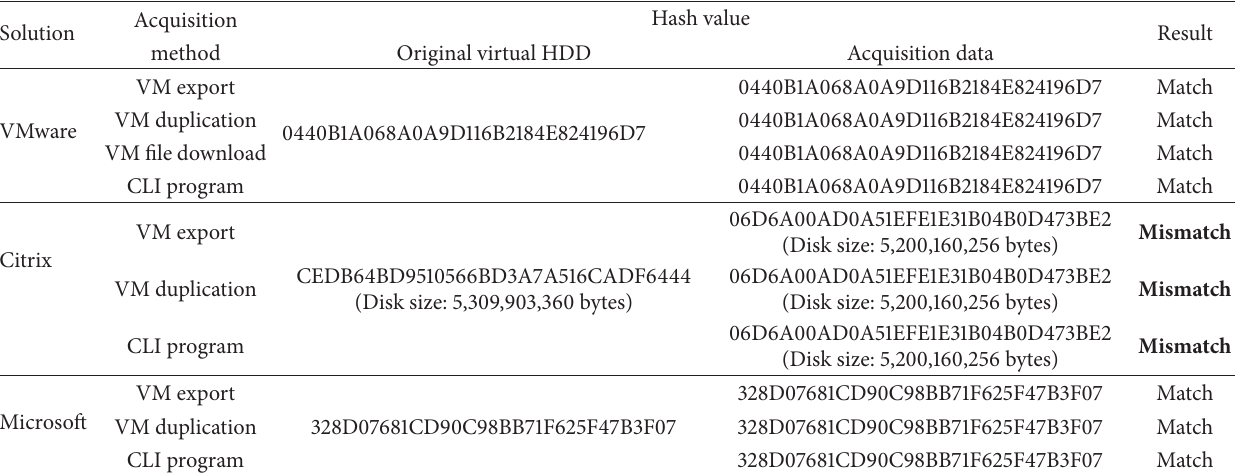
Table 11: Results for experiment #1 on integrity